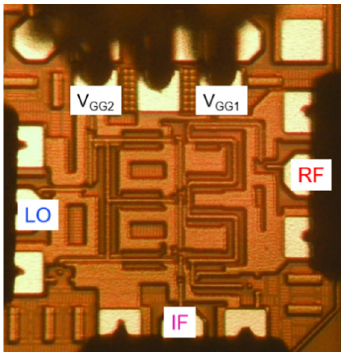
Figure 15. Chip photograph of the fabricated mixer (size: 0.8 × 0.7 mm 2 ).